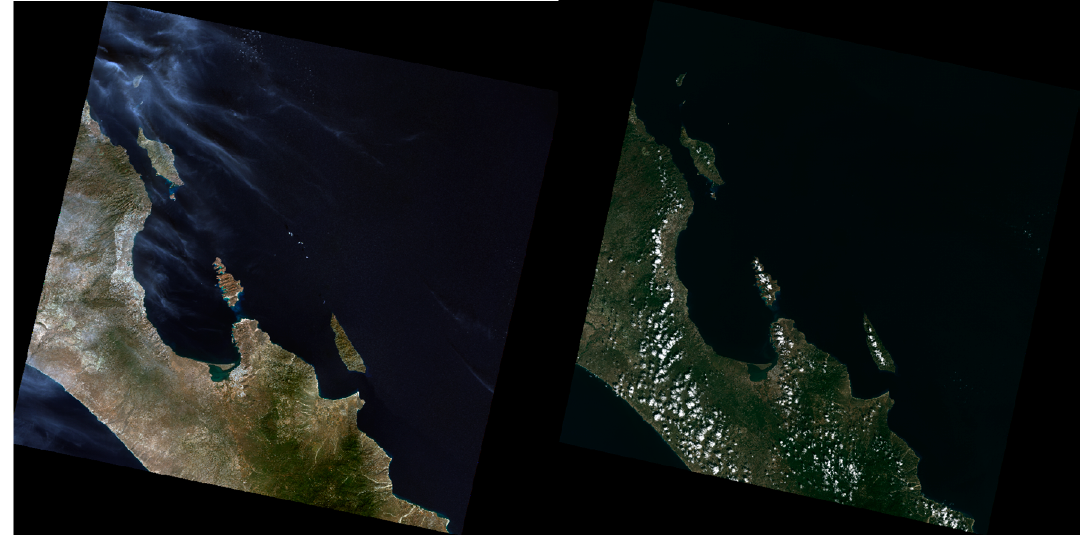
Figure A1. Example of complex atmosphere conditions.